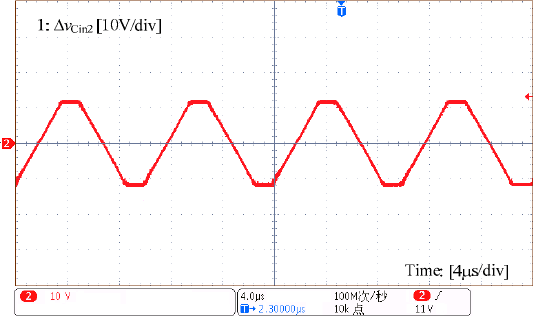
Energies 2018 , 11 , x